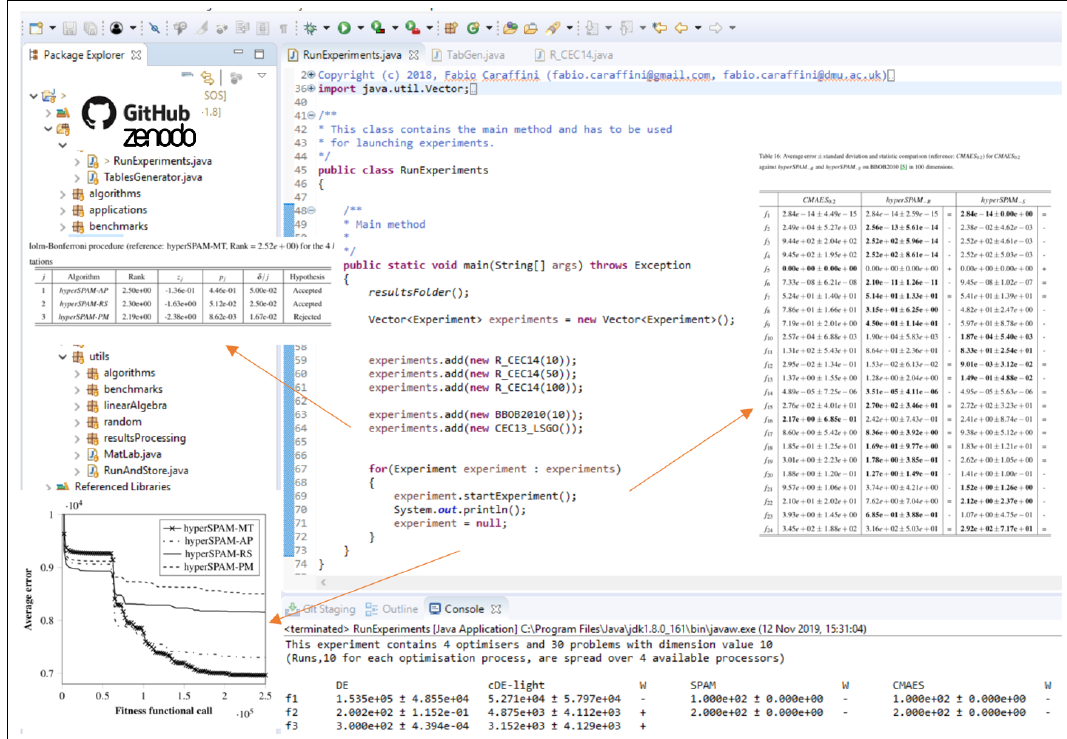
Figure 1. A graphical functional overview of the Stochastic Optimisation Software (SOS)